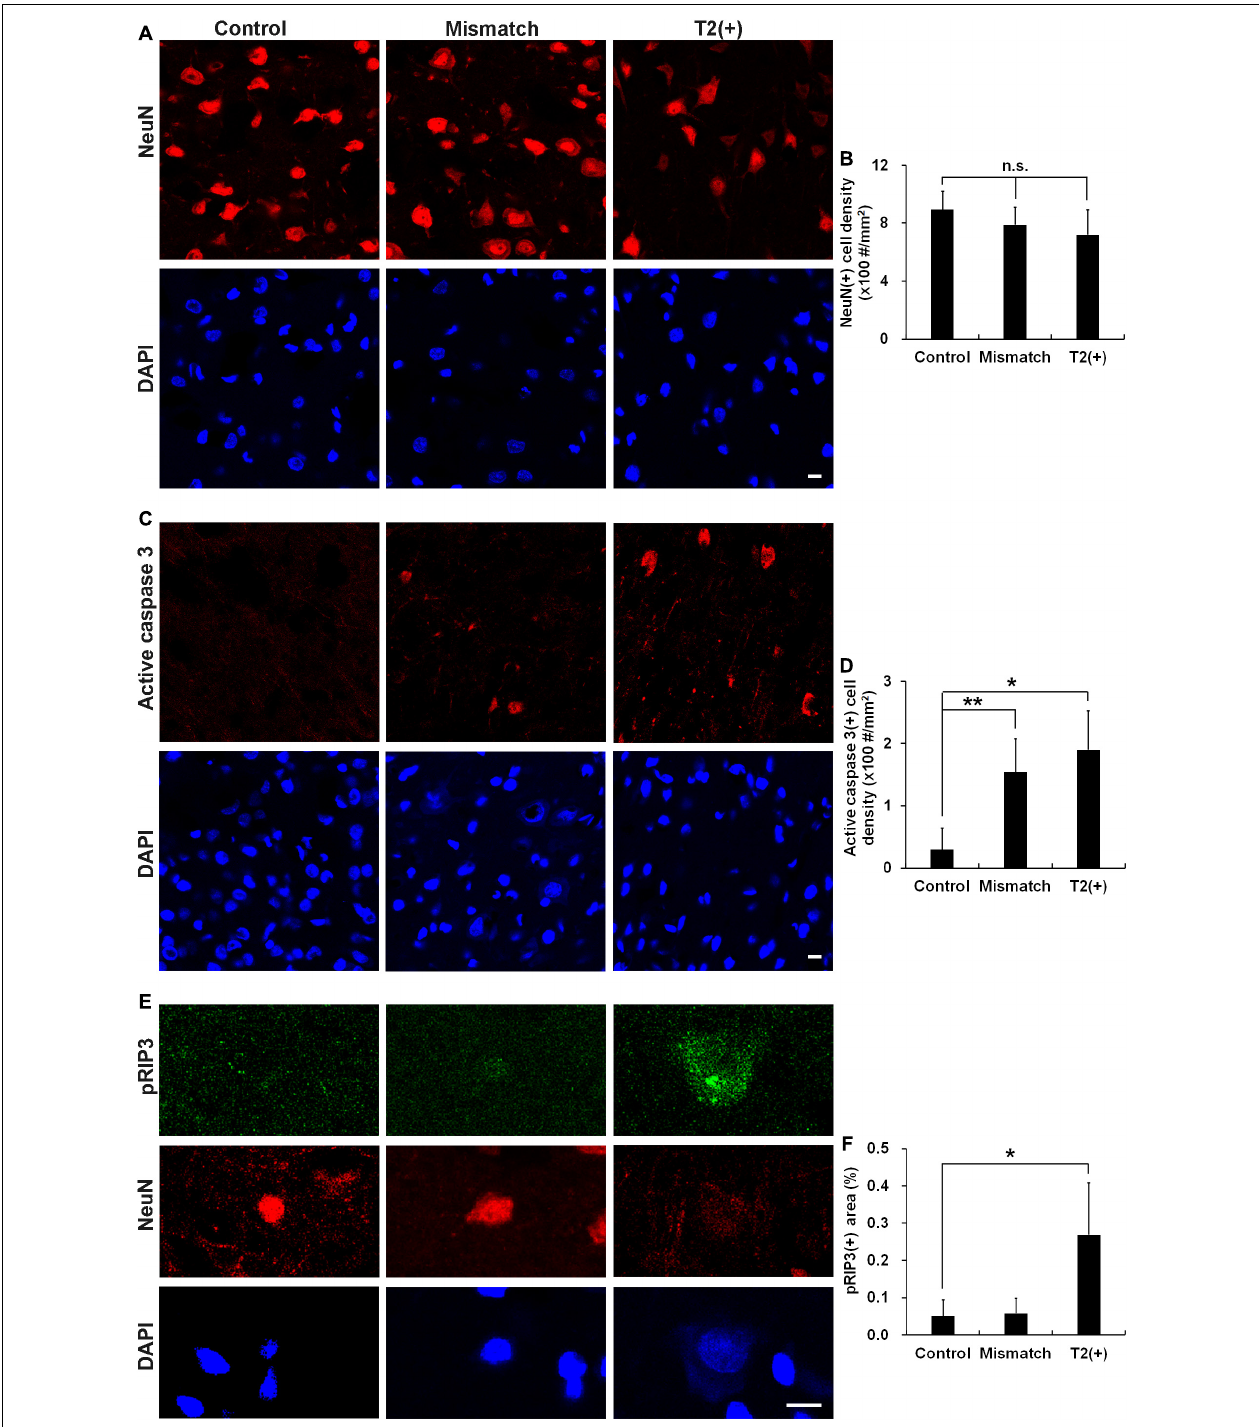
FIGURE 2 | Cell densities, apoptosis, and necroptosis in the T2(+), mismatch, and control regions. (A,B) Staining results of NeuN and DAPI in the T2(+), mismatch, and control areas. NeuN(+) cell densities (#/mm 2 ) were not different among the three regions ( p = 0.399). (C,D) Staining results of active caspase 3 in the three regions. Active caspase 3 was observed in some neurons in the mismatch and T2(+) regions. The cell densities of active caspase 3(+) in the mismatch and T2(+) regions were significantly higher than those in the control regions ( p = 0.009 and 0.019 by paired t -test, respectively; p = 0.008 for comparison of the three regions). (E) The expression of pRIP3 was obvious in some swollen neurons in the T2(+) regions. (F) The expression area proportion of pRIP3 [the area of pRIP3(+) divided by the total analyzed area] were significantly larger in the T2(+)regions than in the control areas ( p = 0.022 by paired t -test; p = 0.021 for comparison of the three regions). * p < 0.05; ** p < 0.01. N = 4 rats in each group. Scale bars = 10 µ